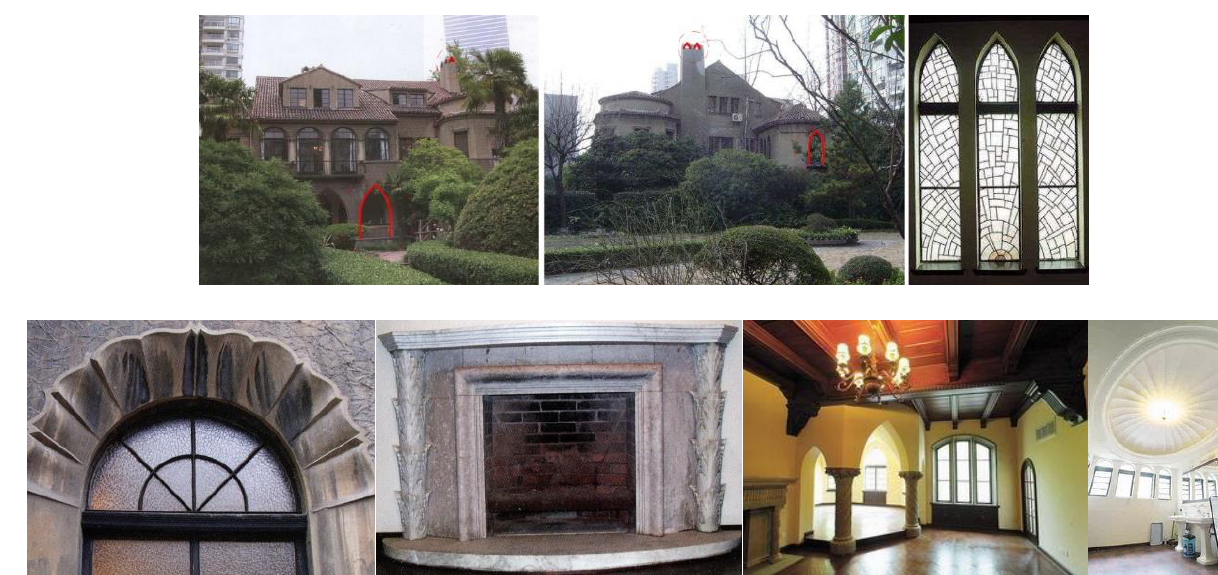
Figure 12. Sun Ke House — neo-Gothic (first row) and Art Nouveau (second row) .